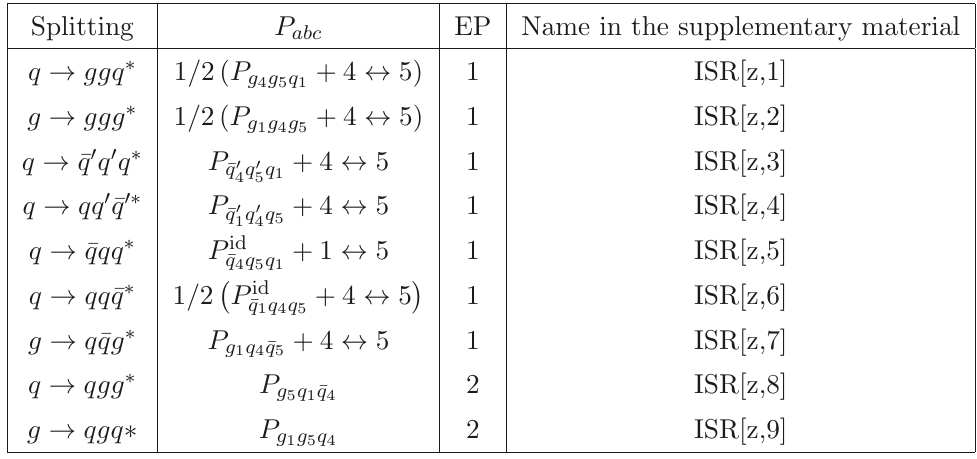
Table 1 . Overview of integrated triple-collinear subtraction terms for initial state splittings.